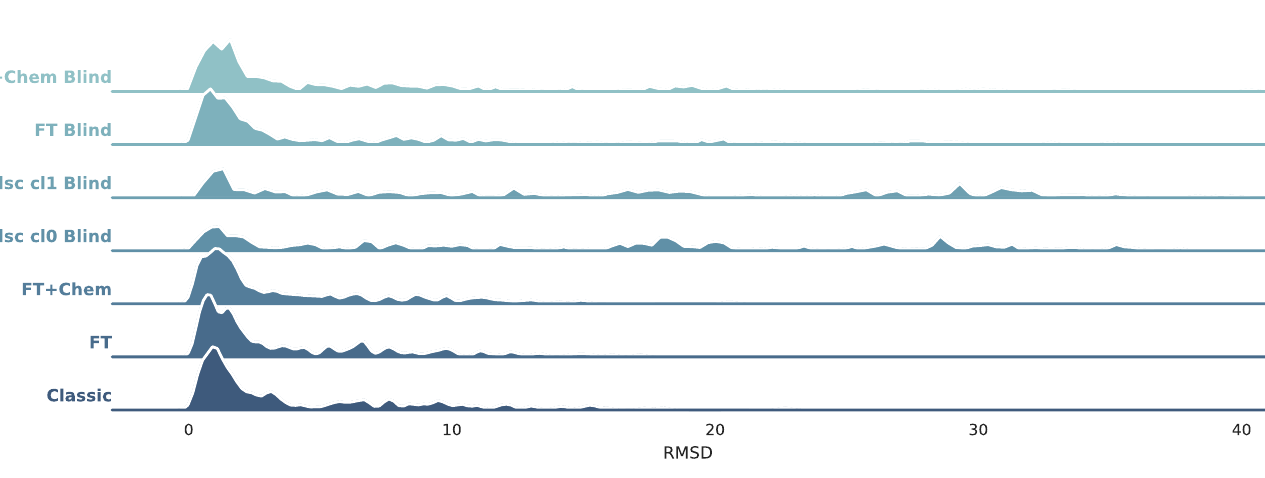
Figure 3. Kernel Density Estimate (KDE) plots for each benchmarking